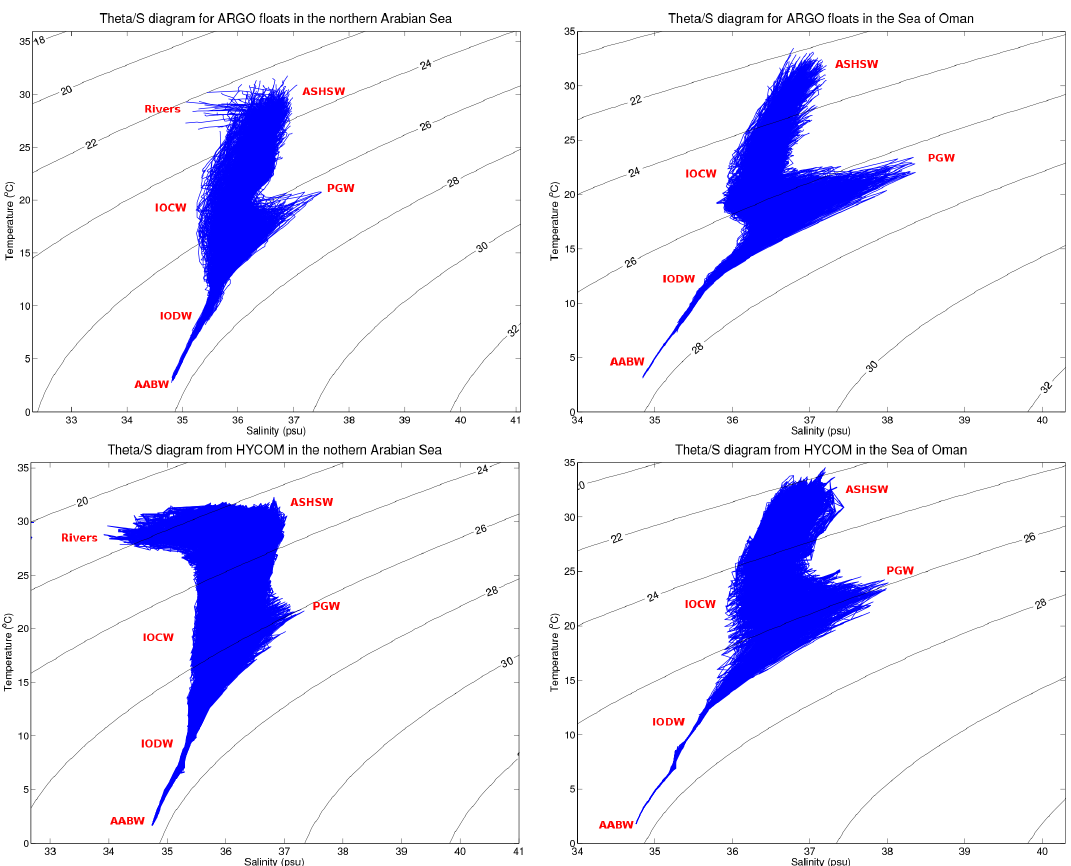
Figure 4. Temperature versus salinity diagram in the Sea of Oman (left) and in the northern Arabian Sea (right), from the ARGO float (top) and the HYCOM simulation (bottom). The different water masses are Arabian Sea High Salinity Water (ASHSW), Persian Gulf Water (PGW), Indian Ocean Central Water (IOCW), Indian Ocean Deep Water (IODW), and Antarctic Bottom Water (AABW).